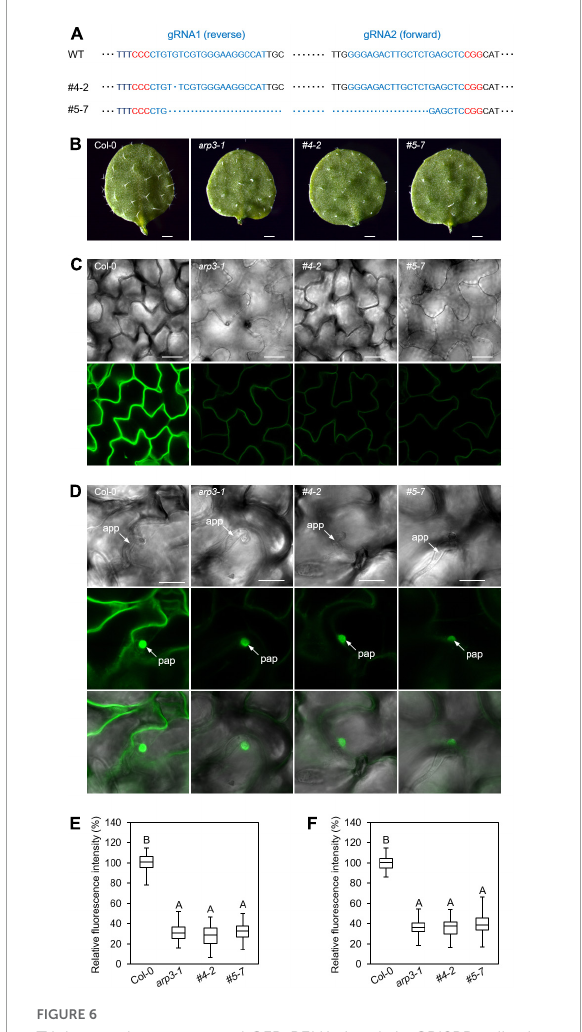
FIGURE6 Trichome phenotypes and GFP-PEN1 signals in CRISPR-edited stable T2 transgenic lines. (A) Sequence variants of gRNA loci detected in two T2 homozygous transgenic plants. The sequences of the unmodified locus for gRNA1 and gRNA2 in WT are shown on the top. gRNA target sites are in blue and PAM sequences are in red. The deletions in T2 transgenic plants, #4-2 and #5-7, are indicated below the WT by blue dots. The gRNA3 loci from these two plants are both non-edited. In total, 15 of the progenies from these two lines (T3) were sequenced, respectively, and the deletions of gRNA1 and gRNA2 loci are the same as the sequences shown in this figure. (B) Overview of trichomes on the first true leaf of 2-week-old plants from WT, arp3-1 mutant, #4-2, and #5-7 T2 transgenic lines. Bars, 1 mm. (C) Representative confocal images of GFP-PEN1 in the leaf epidermis of 2-week-old plants. The images were captured by confocal microscopy with the same setting. Bars, 100 µ m. (D) Accumulation of GFP-PEN1 at the Bgh -attempted penetration sites. Leaves of indicated genotypes were inoculated with Bgh and examined for GFP-PEN1 signals by confocal microscopy with the same setting at 24 hpi. Bars, 20 µ m. (E,F) Boxplots displaying relative fluorescence intensity of GFP-PEN1 signal intensity at the PM (C) or papillae (D) in the indicated genotypes as described. Quantitative analysis was performed from 30 cells of five plants per genotype. Different letters indicate statistically significant differences determined by one-way ANOVA with Tukey’s HSD ( p <